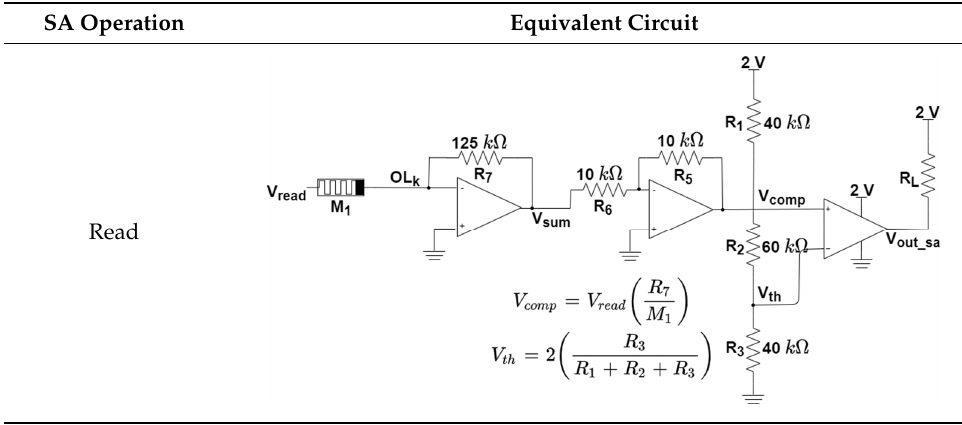
Table A2. Equivalent circuits for all possible configurations of the alternative sensing module.